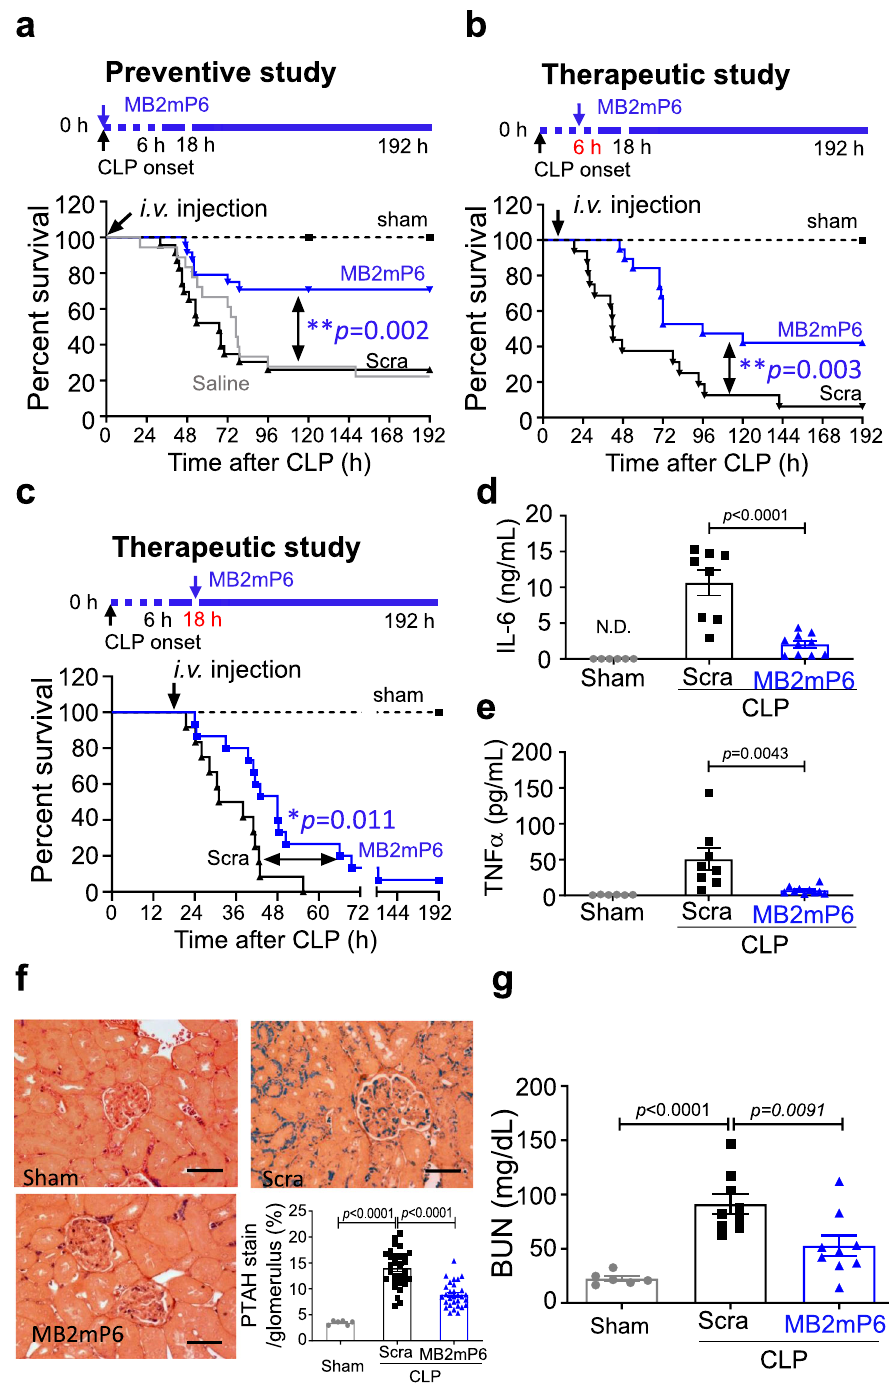
glomerular microvascular thrombosis and kidney function impairment (indicated by blood BUN levels 24 h after CLP) were both markedly reduced in G α 13 fl / fl -PF4Cre mice compared with G α 13 fl / fl mice (Fig. 7g, h). Thus platelet G α 13 plays an important role in glomerular microvascular thrombosis and kidney injury during sepsis, and is likely responsible for the therapeutic effect of MB2mP6 on glomerular thrombosis and kidney injury. However, the serum level of the in fl ammatory cytokine TNF α was not signi fi cantly reduced in G α 13 fl / fl -PF4Cre mice (Fig. 7i), although cytokine IL-6, levels in mouse serum were partially